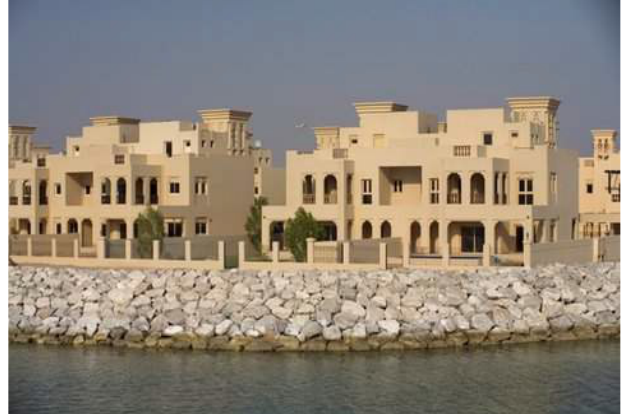
Figure 4. Duplex villa in Al hamra.